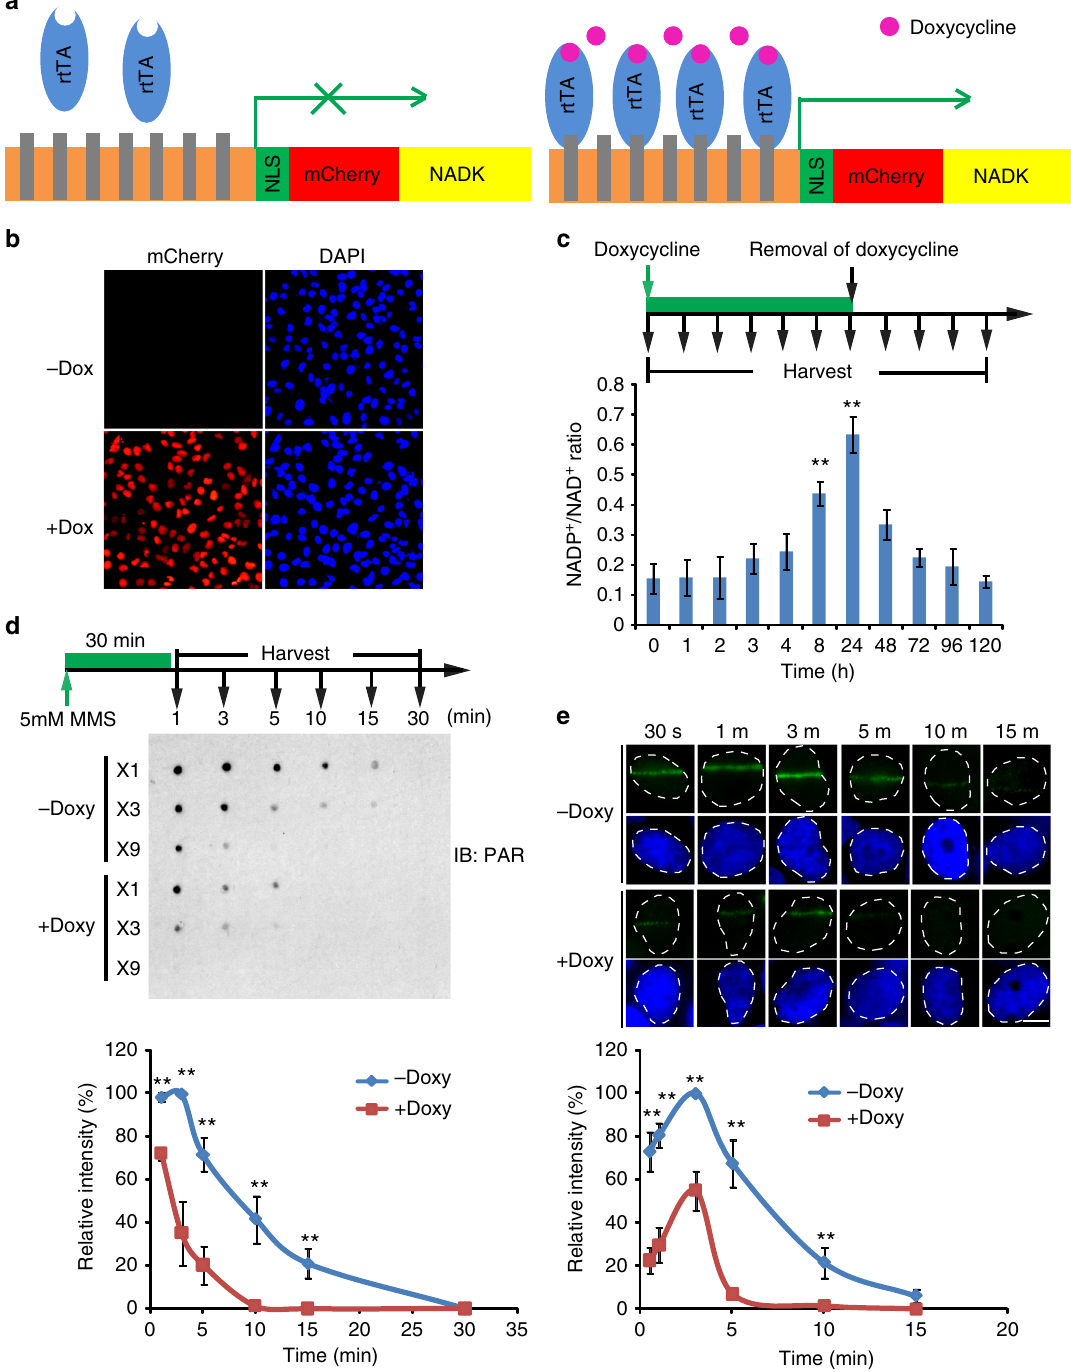
Fig. 4 NADP + negatively regulates DNA damage-induced PARylation in cells. a The schematic diagram shows the tetracycline-inducible expression of NADK. A nuclear localization signal (NLS) and mCherry were added at the N-terminus of NADK. The Tet-on system is from Addgene. b Doxycycline induces the expression of NADK (mCherry) in U2OS cells. c The NADP + /NAD + ratio in U2OS cells is signi fi cantly increased following doxycycline induction. Three independent experiments were performed. Data are presented as mean ± SD. ** p < 0.01. Data were analyzed using two-tailed unpaired Student ’ s t tests. d High level of NADP + suppresses the DNA damage-induced PARylation. The cells were treated with 10 mM methyl methanesulfonate. Dot blotting was performed to examine PARylation at the indicated time points after DNA damage. The samples were also diluted three times (3×) or 9 times (9×) in the same dot blotting to avoid sample loading variation. Three independent experiments were performed. Data are presented as mean ± SD, ** p < 0.01. Data were analyzed using two-tailed unpaired Student ’ s t tests. e Kinetics of PARylation at DNA lesions. The cells were treated with laser microirradiation. PARylation at the laser stripes was examined by immuno fl uorescence staining with anti-PAR antibody. Representative cells at different time points are shown. The relative signal strength of PAR was summarized from three independent experiments and at least 15 cells at each time point in each experiment. Data are presented as mean ± SD. Bars: 10 μ M. ** p < 0.01. Data were analyzed using two-tailed unpaired Student ’ s t